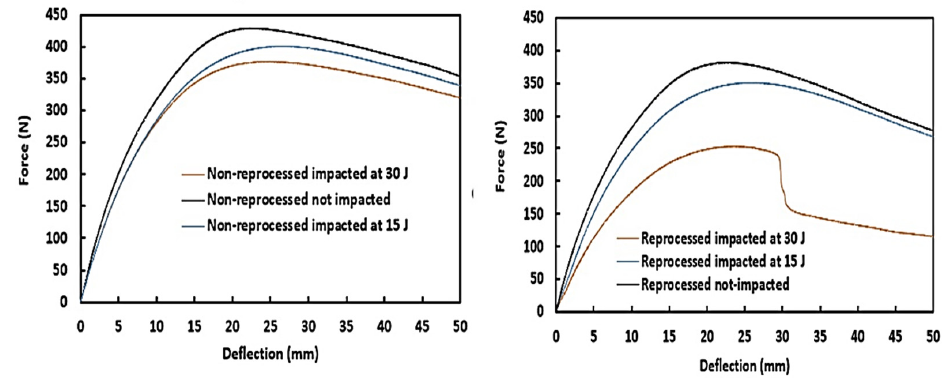
Figure 8. Force-deflection curves at FAI tests of non-reprocessed and reprocessed sandwich structures using three-point-bending test set-up. Table 3. Flexure-after-impact (FAI) properties of sandwich